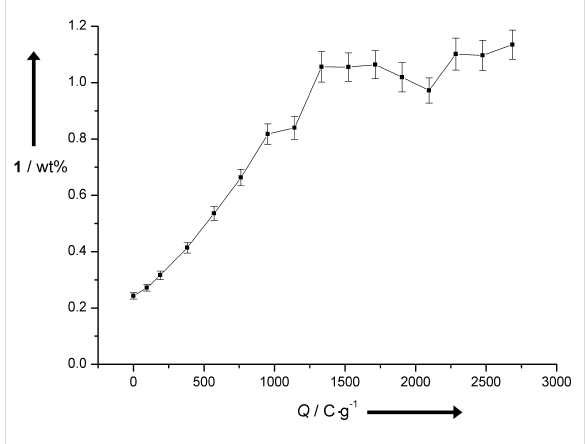
Figure 5: Influence of the applied current onto the yield of 1 by electro- chemical degradation of lignin using stainless steel electrodes, applying a current density of 38 mA ∙ cm − 2